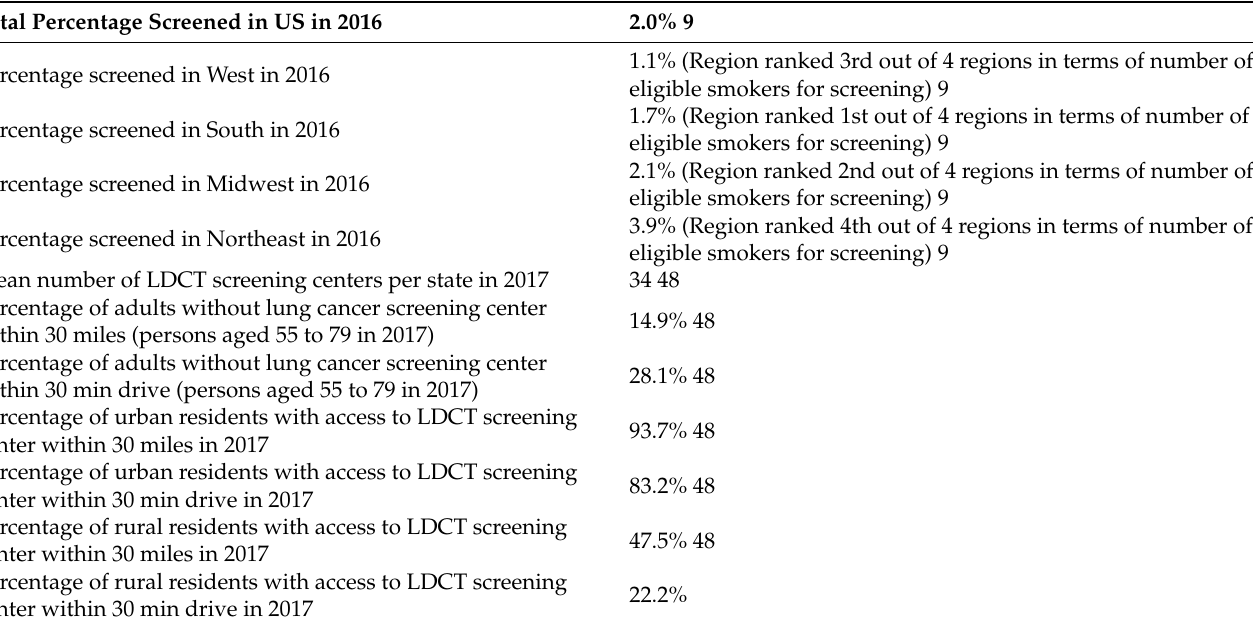
Table 1. Rates of Screening by Region in the United